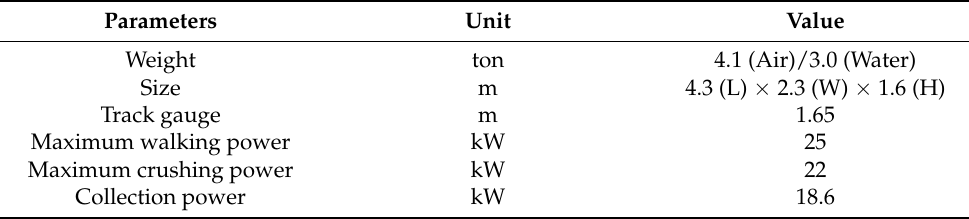
Figure 1. Essential functions of the mining vehicle. Table 1. Essential parameters of the mining